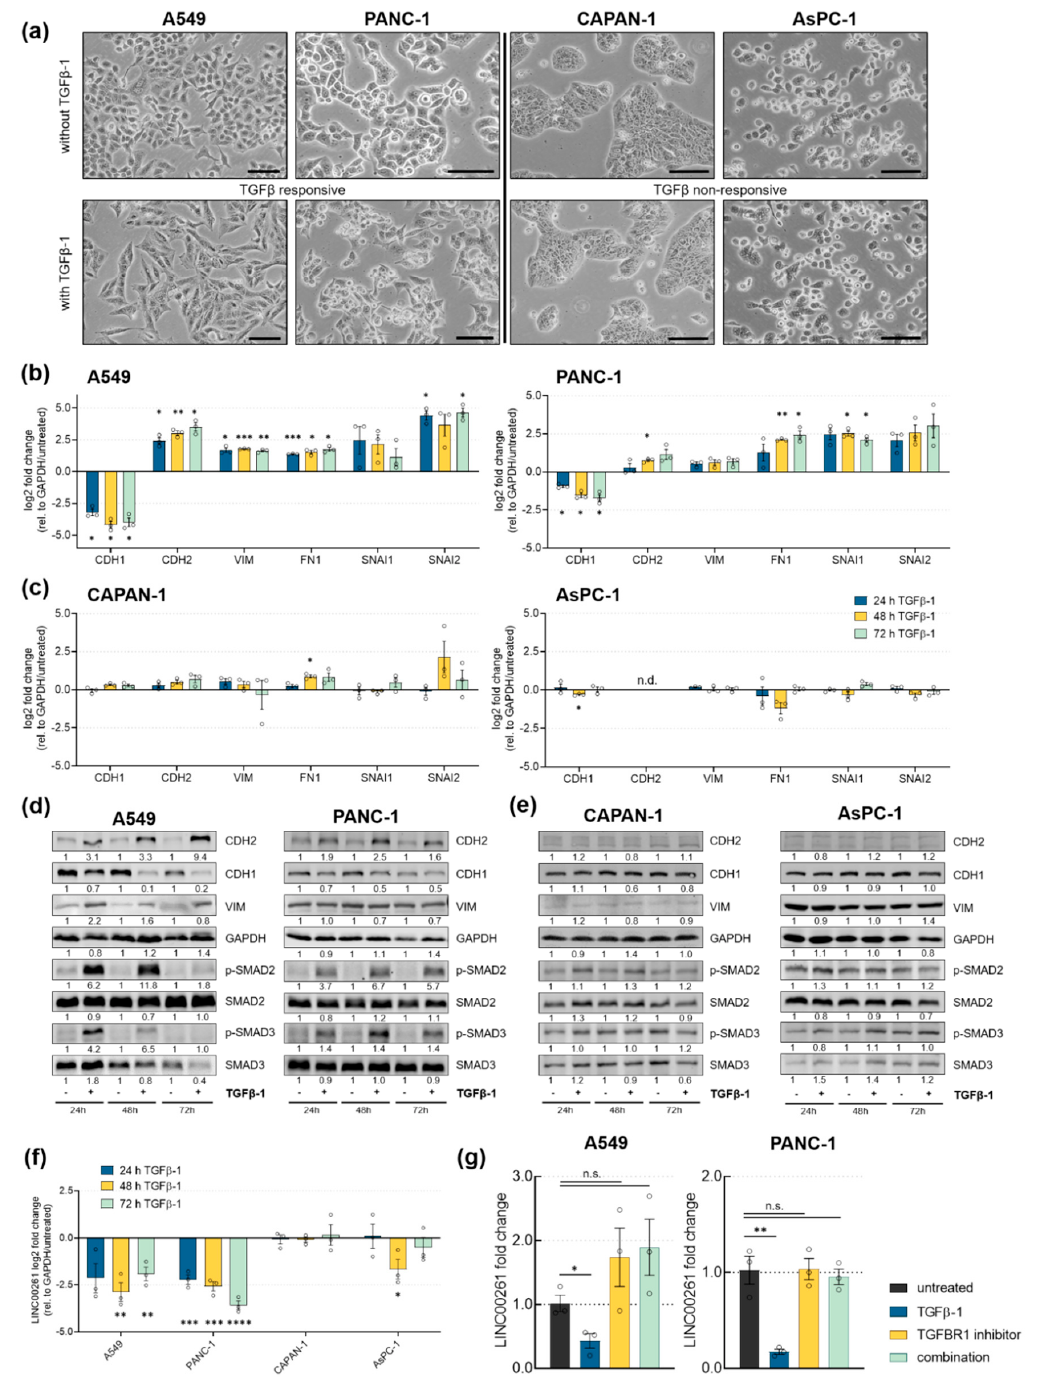
Figure 4. Transforming growth factor β (TGF β ) downregulates LINC00261 expression in cell lines that show TGF β -induced EMT. ( a ) Brightfield images of untreated and TGF β -1 treated A549, PANC-1 (TGF β -responsive), AsPC-1, and CAPAN-1 cells (TGF β -non-responsive). Scale bar = 100 µm. Analysis of mRNA ( b,c ) and protein levels ( d,e ) of genes associated with EMT was done by qRT-PCR and Western Blot, respectively (* p < 0.05, ** p < 0.01, *** p < 0.001, two-way ANOVA). ( f ) LINC00261 expression in TGF β -responsive and non-responsive cells using qRT-PCR (* p < 0.05, ** p < 0.01, *** p < 0.001, **** p < 0.0001, unpaired t-test). ( g ) LINC00261 regulation in A549 and PANC-1 cells treated with TGF β -1, TGFBR1 inhibitor (RepSox), or both after 72 h, measured by qRT-PCR (* p < 0.05, ** p < 0.01, unpaired t -test).